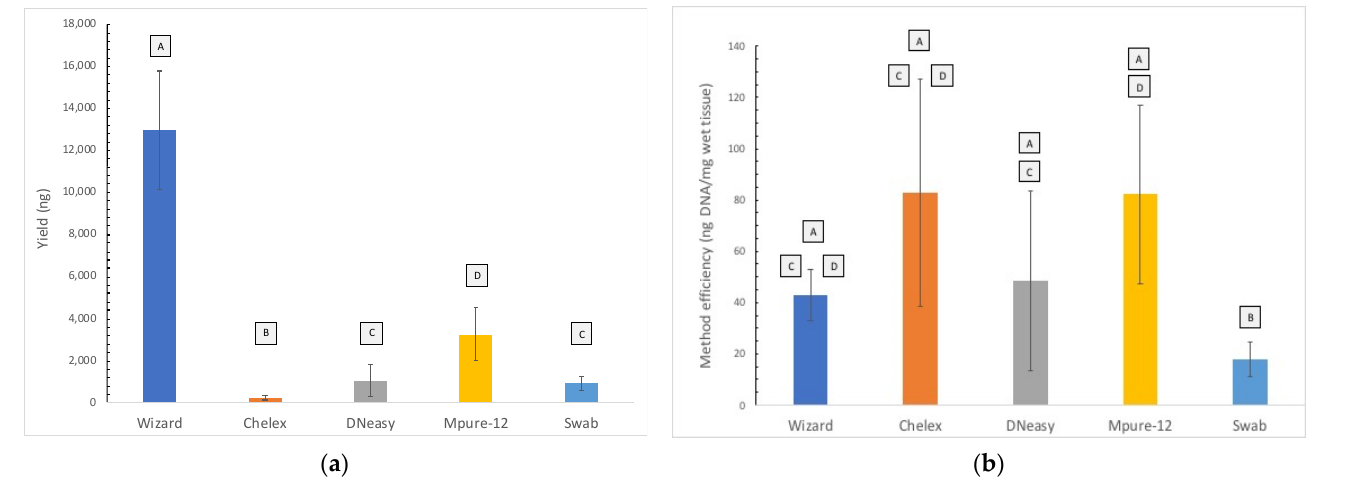
Figure 1. ( a ) Yield (ng) of the tested DNA extraction methods. Data are presented as mean ± SD of samples per method. Non-identical subscript letters (A, B, C, D) indicate a statistically significant difference ( p < 0.05). ( b ) Method efficiency (ng DNA/mg wet tissue) of the tested DNA extraction methods. Data are presented as mean ± SD of samples per method. Non-identical subscript letters (A, B, C, D) indicate a statistically significant difference ( p < 0.05).